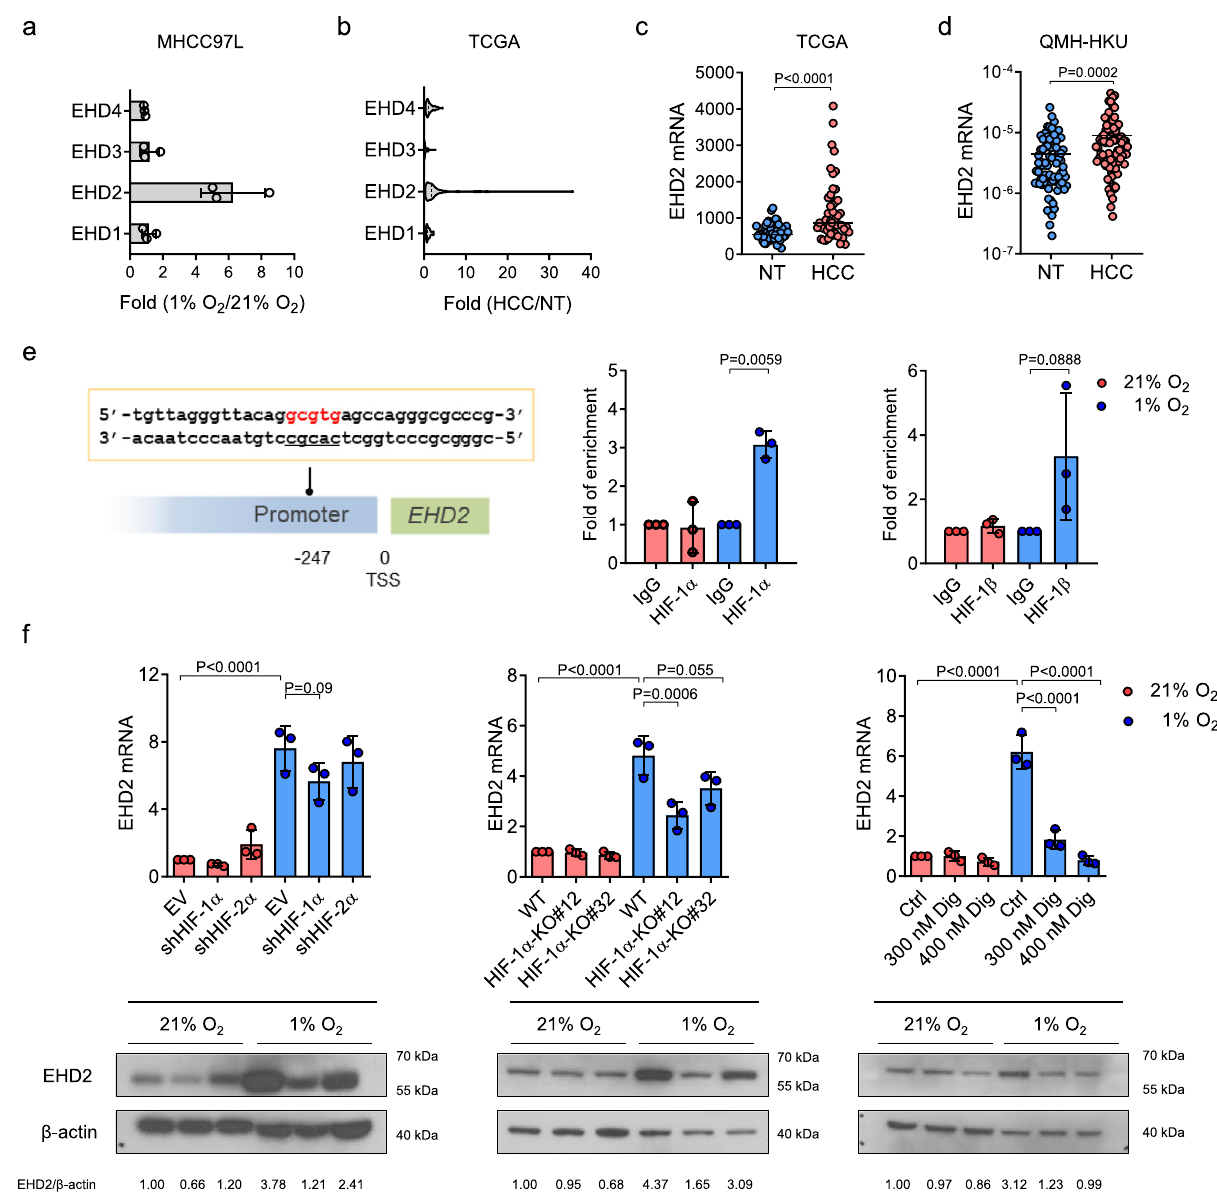
Fig. 3 EHD2 is a HIF transcriptional target overexpressed in HCC. a RT-qPCR data showed mRNA expressions of EHD-family members (EHD1 – EHD4) in MHCC97L cells exposed to 21 and 1% O 2 . Values were normalized to 21% O 2 . mRNA expressions were normalized to 18S. The results were from 3 independent experiments. b Transcriptome sequencing data from the TCGA show the mRNA expressions of EHD1 – EHD4 in 49 pairs of human